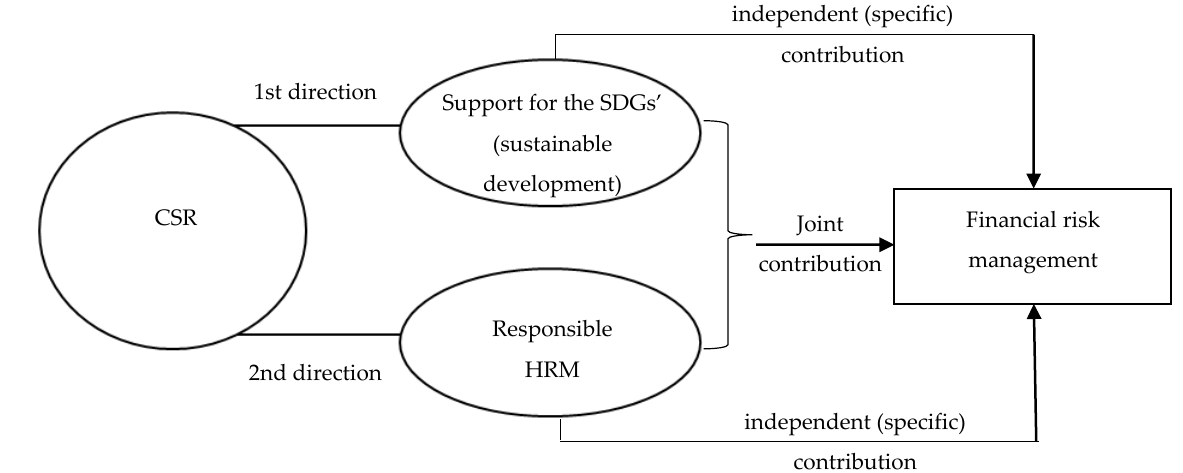
Figure 2. Research model that shows the sense of hypothesis H. Source: authors.